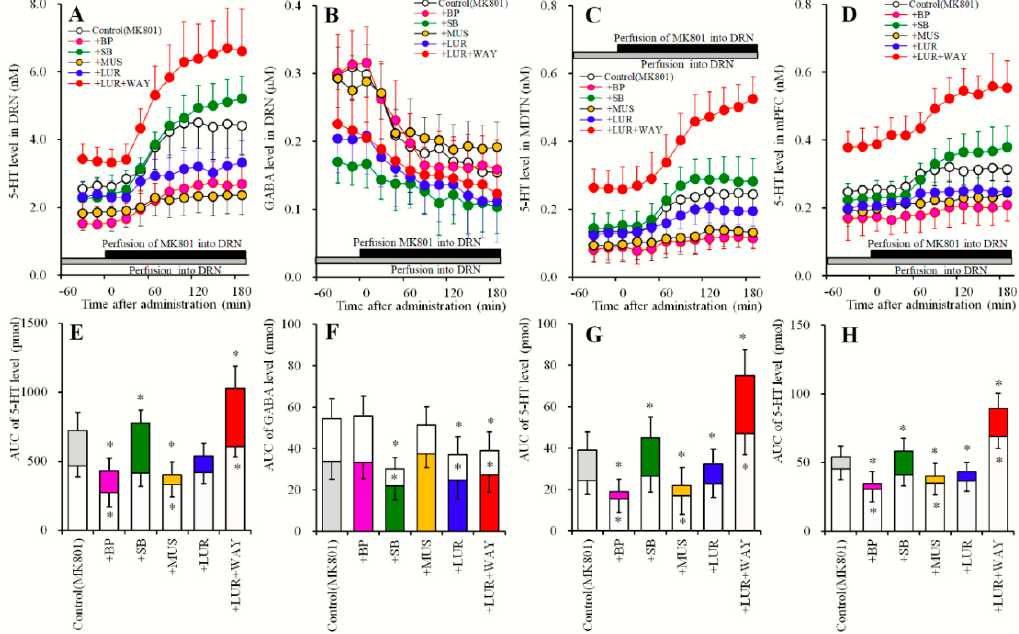
Figure 6. Effects of local administration of BP554, SB269970 and muscimol into the DRN on MK801-evoked 5-HT release in the DRN, MDTN, mPFC and MK801-induced GABA reduction in the DRN (Study_5). ( A ), ( C ) and ( D ) indicate effects of perfusion with BP554 (BP: 10 μ M), SB269970 (SB: 10 μ M) and muscimol (MUS: 1 μ M) on 5 μ M MK801-evoked 5-HT release in the DRN, MDTN and mPFC, respectively. ( B ) indicates effects of perfusion with BP554, SB269970 and muscimol into the DRN on MK801-induced GABA reduction in the DRN. Y -axis: mean ± SD (n = 6) of extracellular levels of 5-HT (nM) and GABA ( μ M); X -axis: time after administration of MK801 (min). Closed bars indicate perfusion with 5 μ M MK801, and gray bars indicate perfusion with target agents. Microdialysis was conducted to measure the releases of 5-HT and GABA. ( E ), ( F ), ( G ) and ( H ) indicate the AUC value of extracellular levels of 5-HT (pmol) and GABA (nmol) during perfusion with MK801 from 20 to 180 min of respective ( A ), ( B ), ( C ) and ( D ). Opened, gray, pink, light blue, green and orange columns represent the AUC values of before and after perfusion with MK801 during perfusion of control, BP554, SB269970 and muscimol, respectively. * P < 0.05; relative to control by MANOVA with Tukey’s post hoc test.